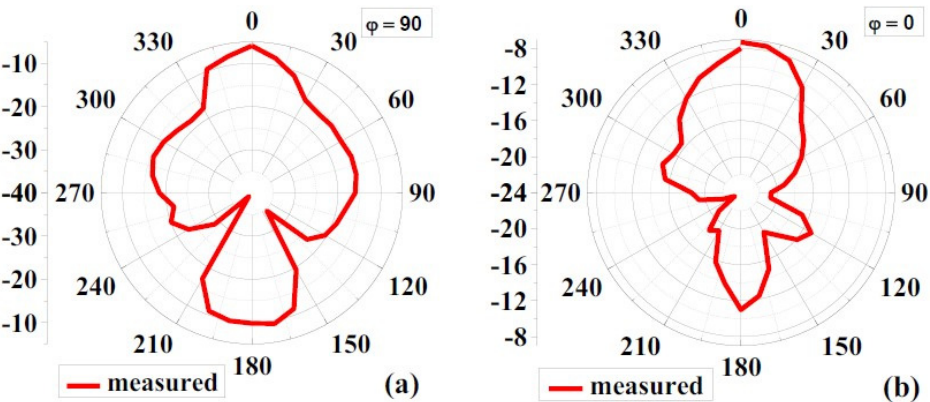
Figure 10. Measured 2D radiation pattern of the proposed antenna without AMC at 8.6GHz: ( a ) φ = 90 and ( b ) φ = 0.